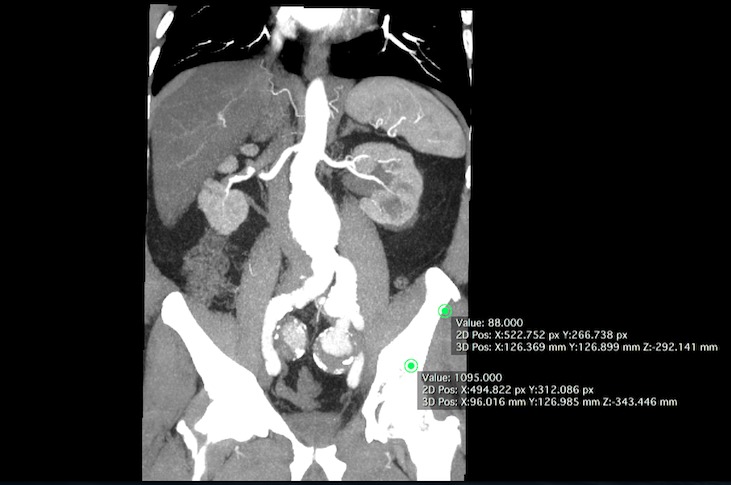
Coronal preoperative angiotomography.